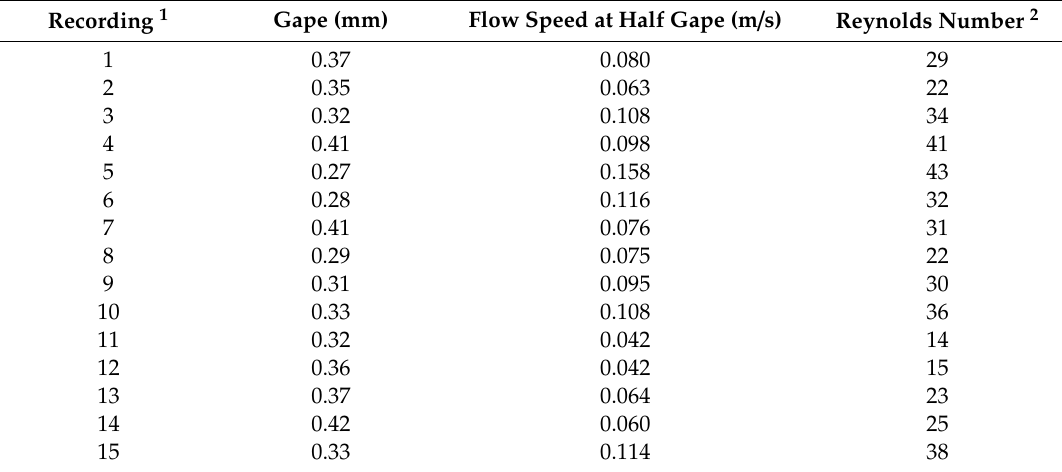
Table A1. Gape and flow sped data for all 15 recordings of bladderwort suction